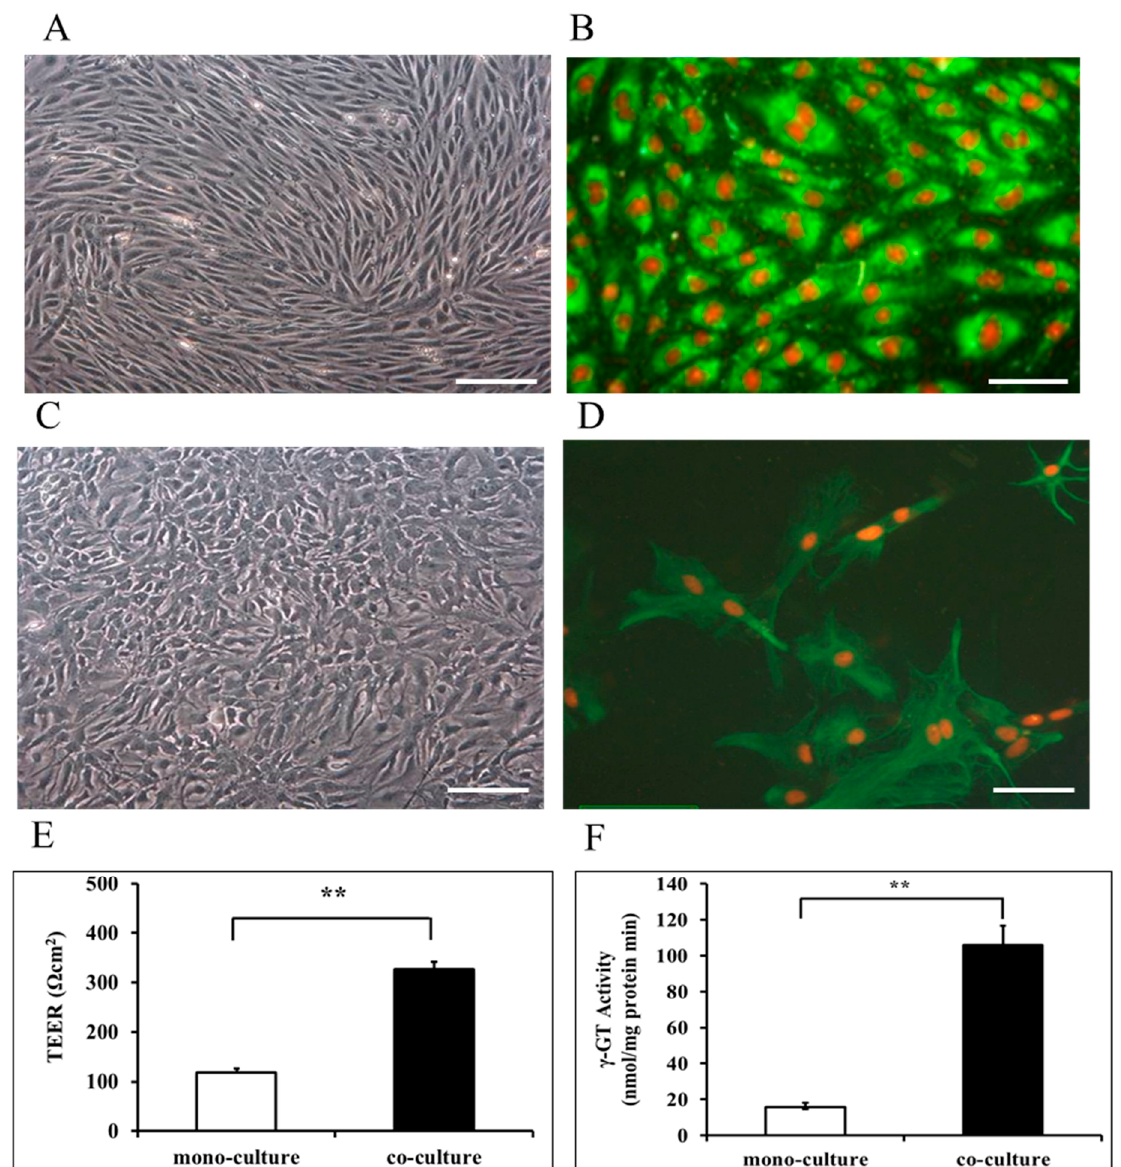
Figure 2. Cell characterization and establishment of the in vitro BBB model. ( A ) Representative image for primary rat BMECs, bar = 100 µ m; ( B ) Representative vWF positive (green) and nucleus (red) immunofluorescence staining of BMECs, bar = 50 µ m; ( C ) Representative image for primary rat astrocytes, bar = 100 µ m; ( D ) Representative GFAP positive (green) and nucleus (red) immunofluorescence staining of astrocytes, bar = 50 µ m; ( E ) TEER in mono-culture of BMECs and co-culture between BMECs and astrocytes; ( F ) γ -GT activity on BMECs. Data are expressed as mean + SD; ** p < 0.01 ( n = 6 per